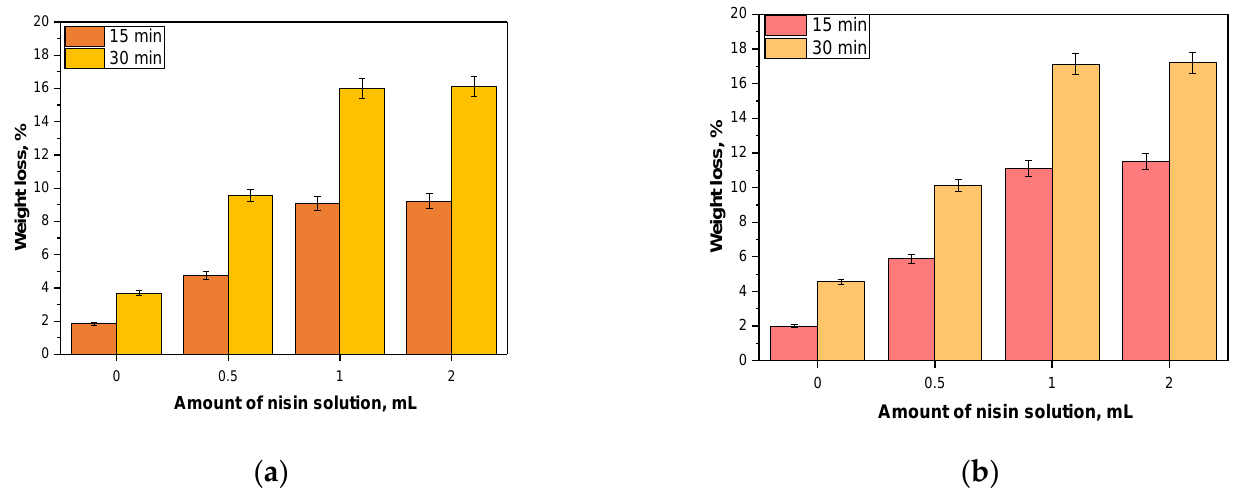
Figure 13. Sorption properties of prepared chitosan/alginate-based capsules ( a ) and alginate-based capsules ( b ).